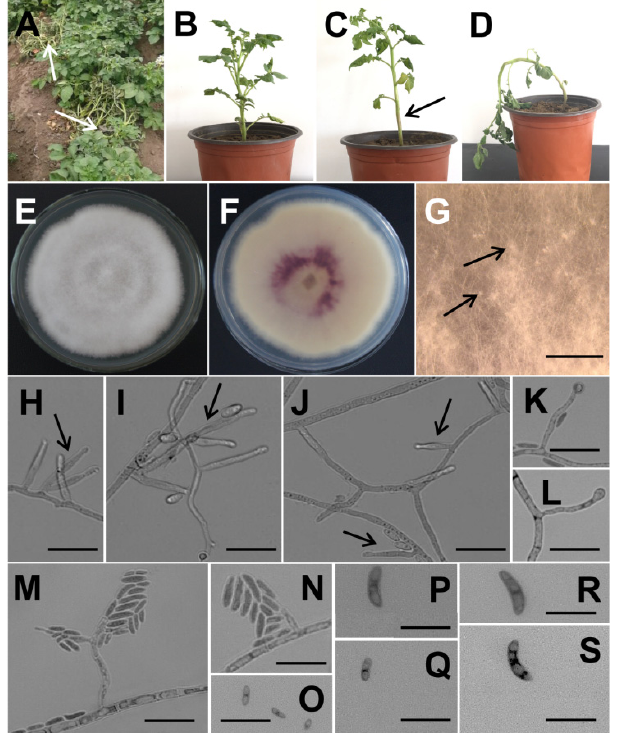
Figure 1. Morphological characteristics of the mycelium and spores of F. foetens and its pathogenicity. ( A ) The potato plants with wilt symptoms in the field. ( B ) Negative control: the potato seedlings in pots inoculated with sterilized water and cultivated in the greenhouse. ( C , D ) the potato seedings after infection with F. foetens for 4 to 6 and 9 days, respectively. ( E , F ) The front and the reverse colony of the F. foetens on PDA, cultured at 25 °C and for 7 days. ( G ) The dotted appearance formed on aerial mycelia, the scale bar is 5 μ m. ( H – J ) The phialides of the mycelium, the scale bar is 20 μ m. ( K , L ), The chlamydospore , the scale bar is 20 μ m. ( M – S ) The microconidia, the scale bar is 20 μ m.